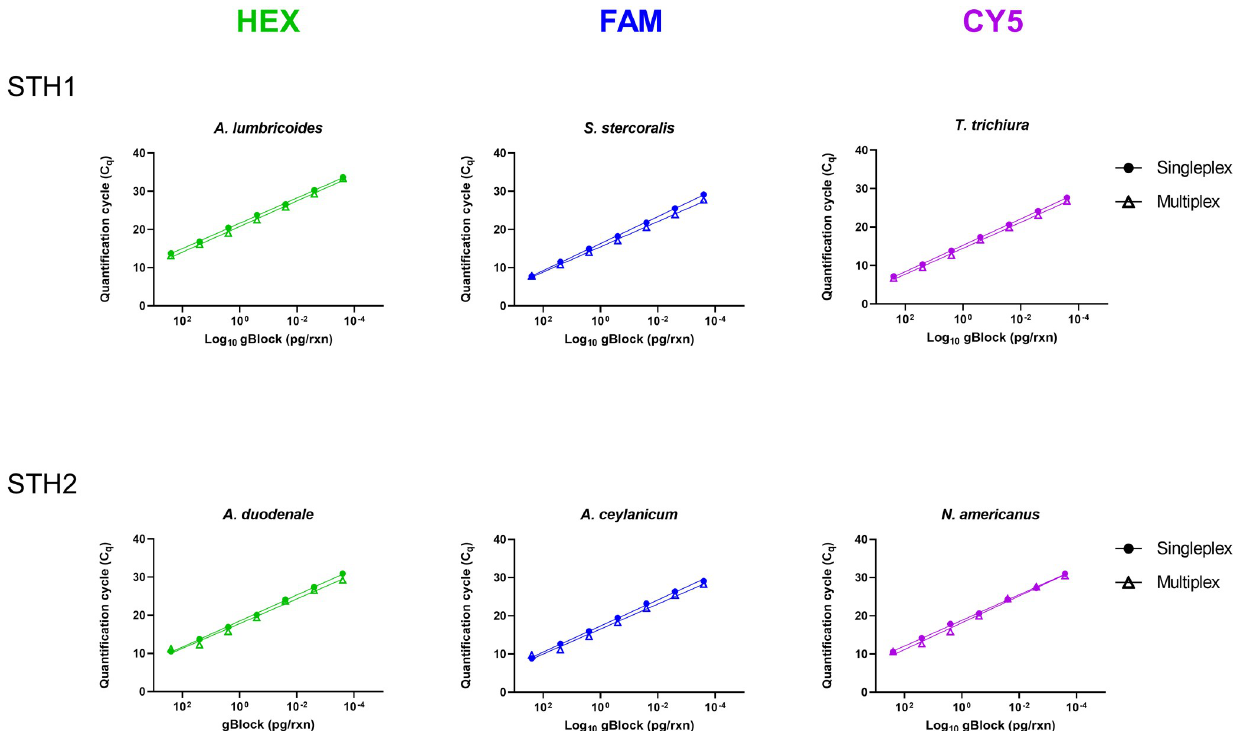
Fig 4. The STH1 and STH2 qPCRs performed as both singleplex and multiplex reactions. Synthetic gBlocks 1 (IDT) mimicking sequences from each of the six parasites were diluted 10-fold to generate 7-point standard curves. Mean C q values and standard deviations from duplicate wells are shown.